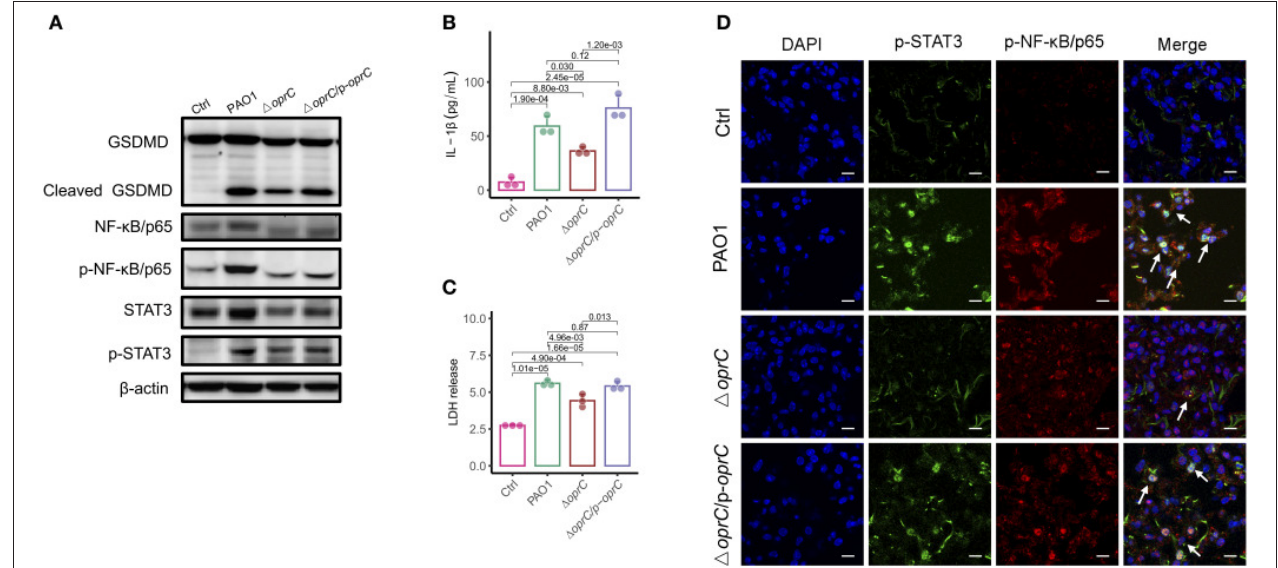
FIGURE 5 | oprC deficiency decreased pyroptosis and STAT3/ NF- κ B phosphorylation. (A) MH-S cells challenged with bacteria at a multiplicity of infection (MOI) of 10 for 2h. Immunoblotting analysis of GSDMD, NF- κ B/p65, p-NF- κ B/p65, STAT3, and p-STAT3. (B,C) Secreted IL-1 β and LDH from the supernatant was assessed by ELISA and LDH assay kit after MH-S cells were infected at an MOI of 10 for 2h ( n = 3). (D) Representative images of immunofluorescence staining of the lungs infected with bacteria for p-STAT3 co-stained with p-NF- κ B/p65 and DAPI ( n = 3). Arrows indicate the colocalizations between p-STAT3 and p-NF- κ B/p65. Scale bars, 10 µ m. Error bars represent the mean ± s.d. One-way ANOVA with a post-hoc Tukey test was performed for comparison of means of